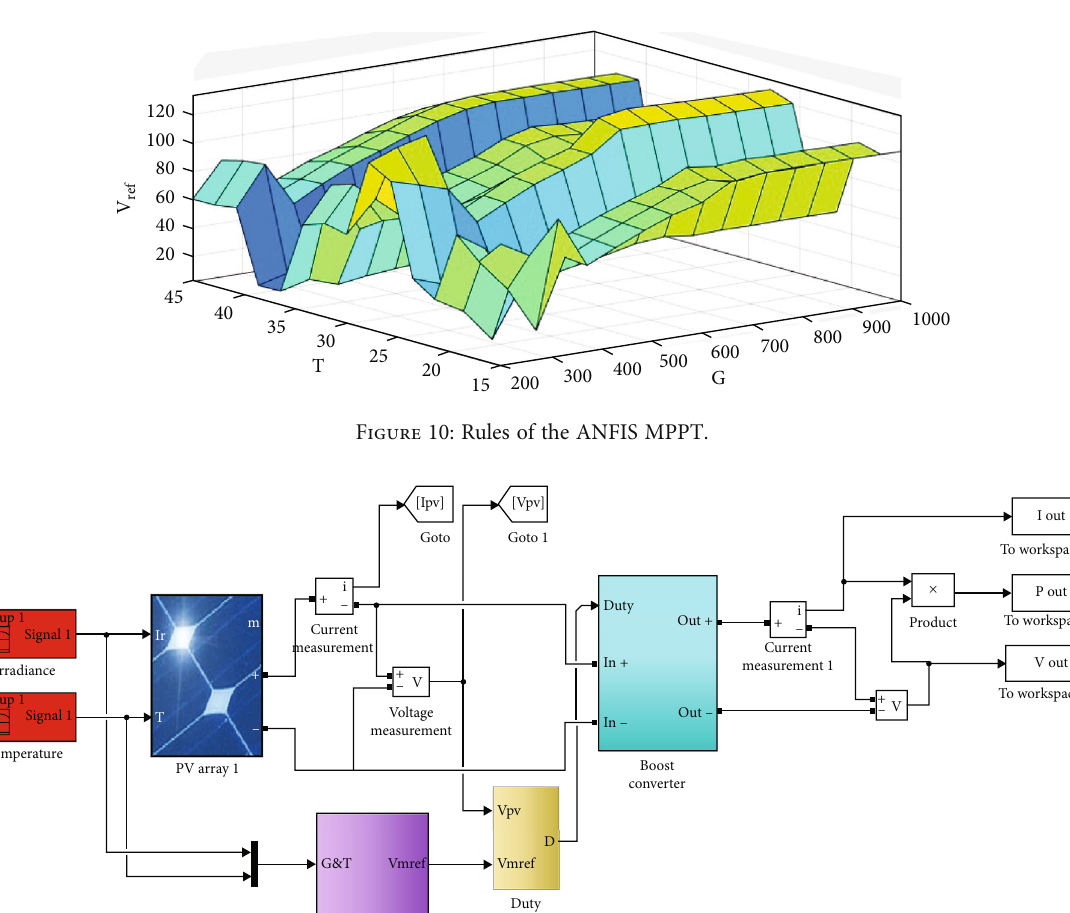
Figure 9: Architecture of the proposed ANFIS MPPT.